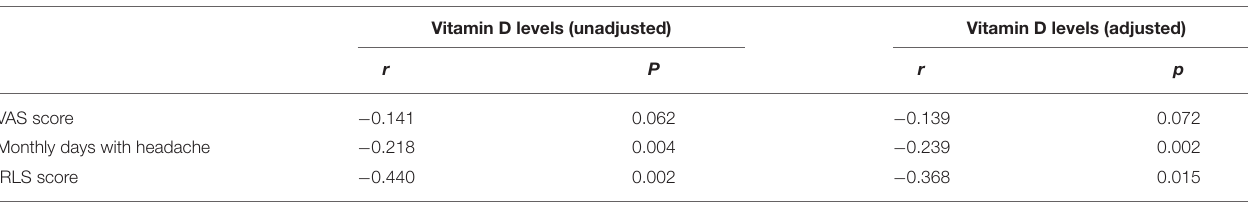
TABLE 4 | Correlation between severity of disease and vitamin D levels. Vitamin D levels (unadjusted) Vitamin D levels